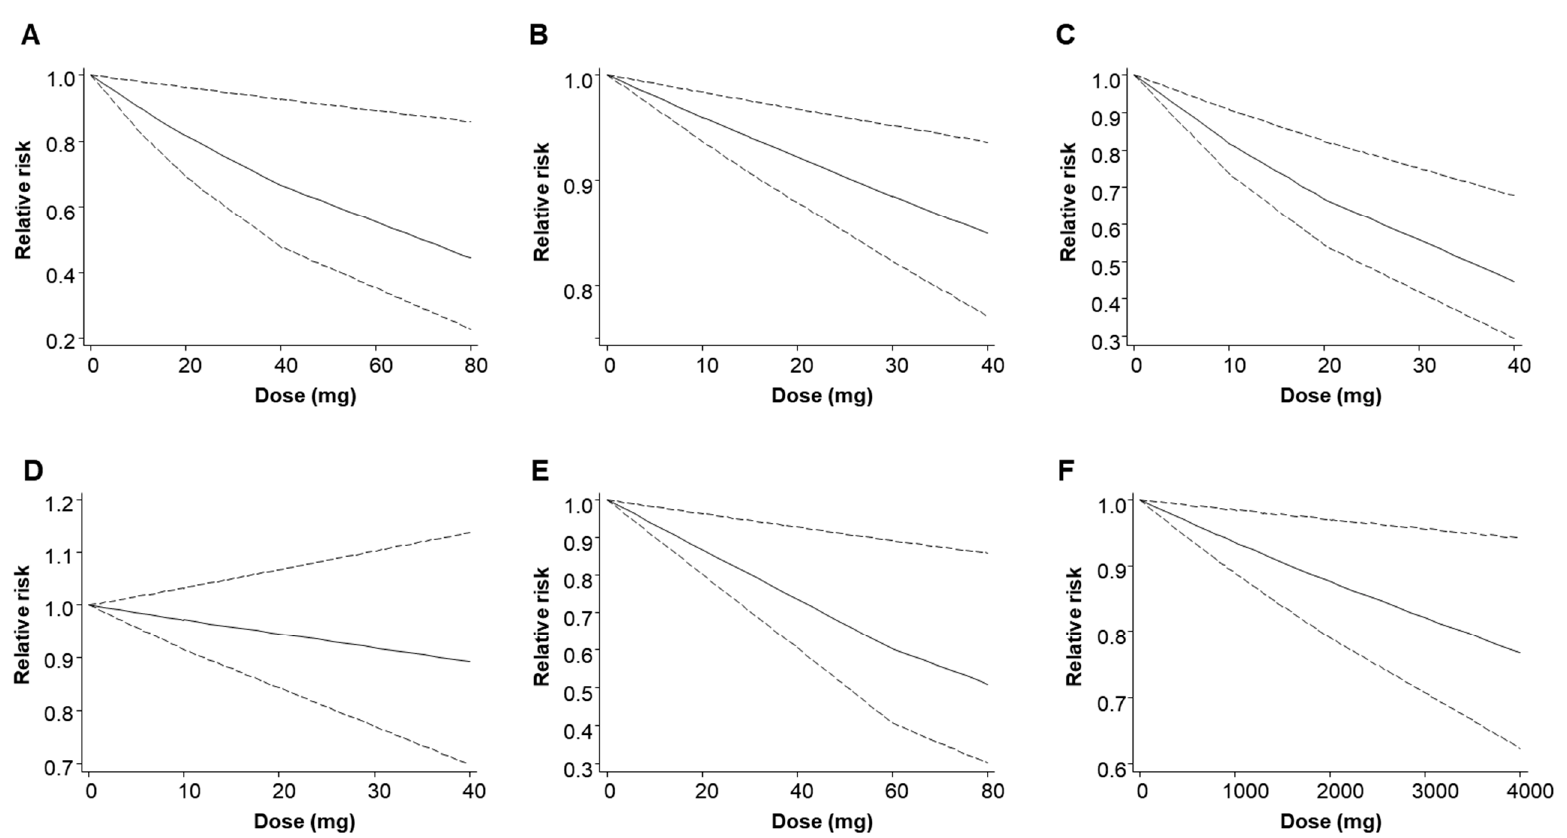
Figure A13. Dose–response meta-analysis of the association between ( A ) atorvastatin, ( B ) pravastatin, ( C ) simvastatin, ( D ) rosuvastain, ( E ) fluvastatin, and ( F ) omega-3 supplementation with cardiovascular death.